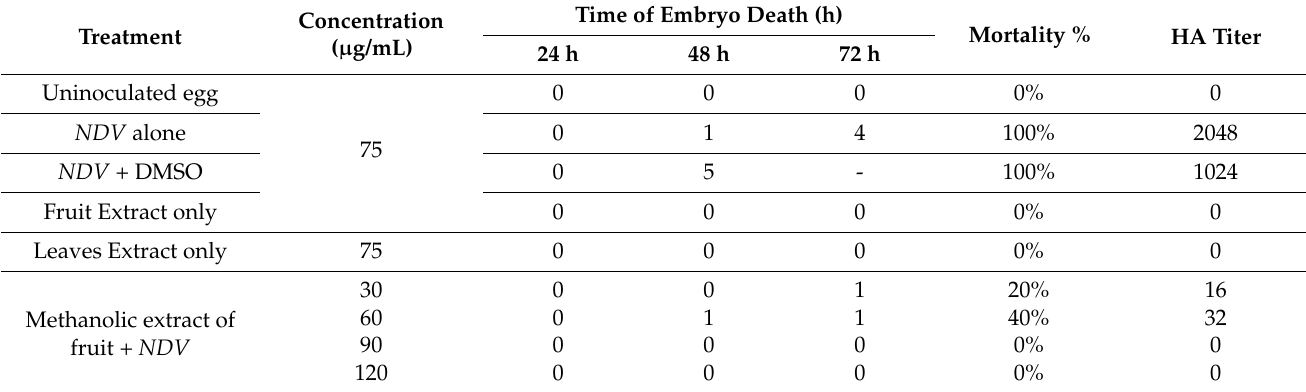
Table 3. Mortality (%) and HA assay of fruit and leaves